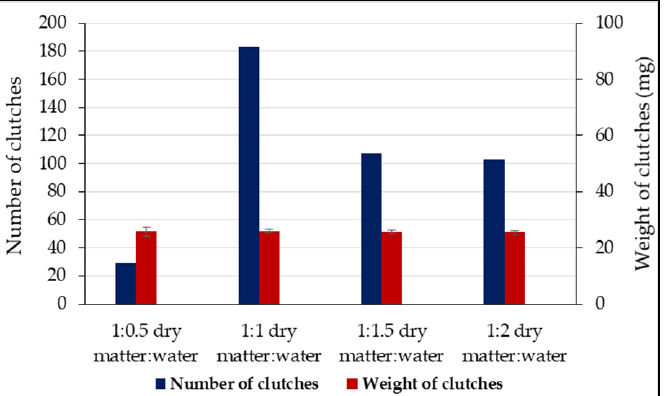
Figure 4. Distribution of the number of clutches (424 egg clutches) and their average weight clutches depending on the humidity of the substrate (Stage II, N = 1000 flies). Error bars depict standard errors of means.